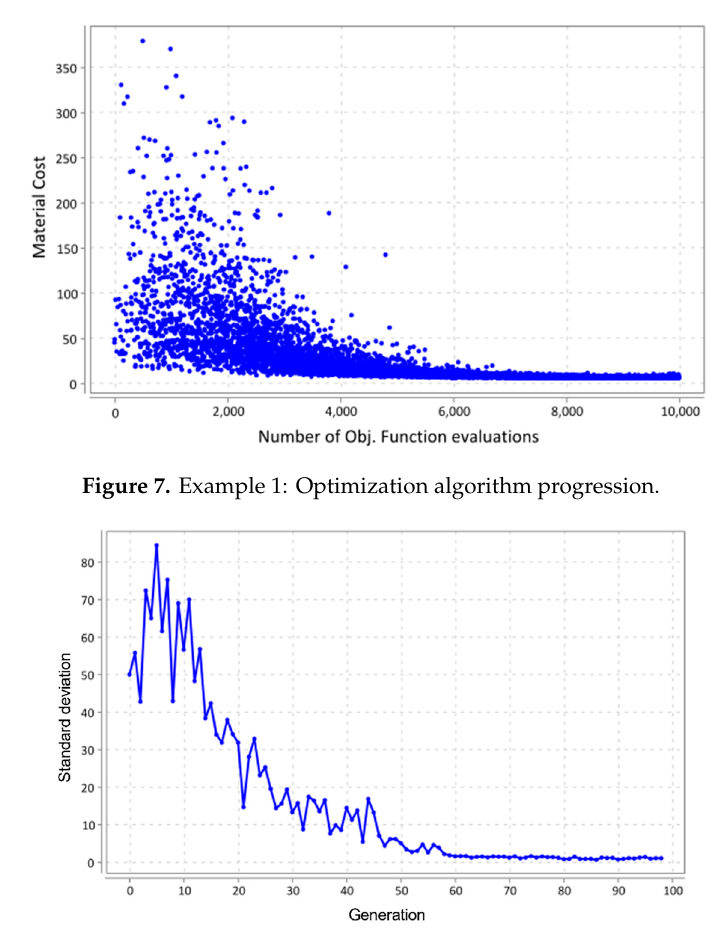
5.547 ¤ Table 7. Example 1: Demand–capacity ratios corresponding to the optimum design vector. Design Check * Figure 9. Example 1: Geometry and pressure distribution (service combination) of the obtained optimum design.